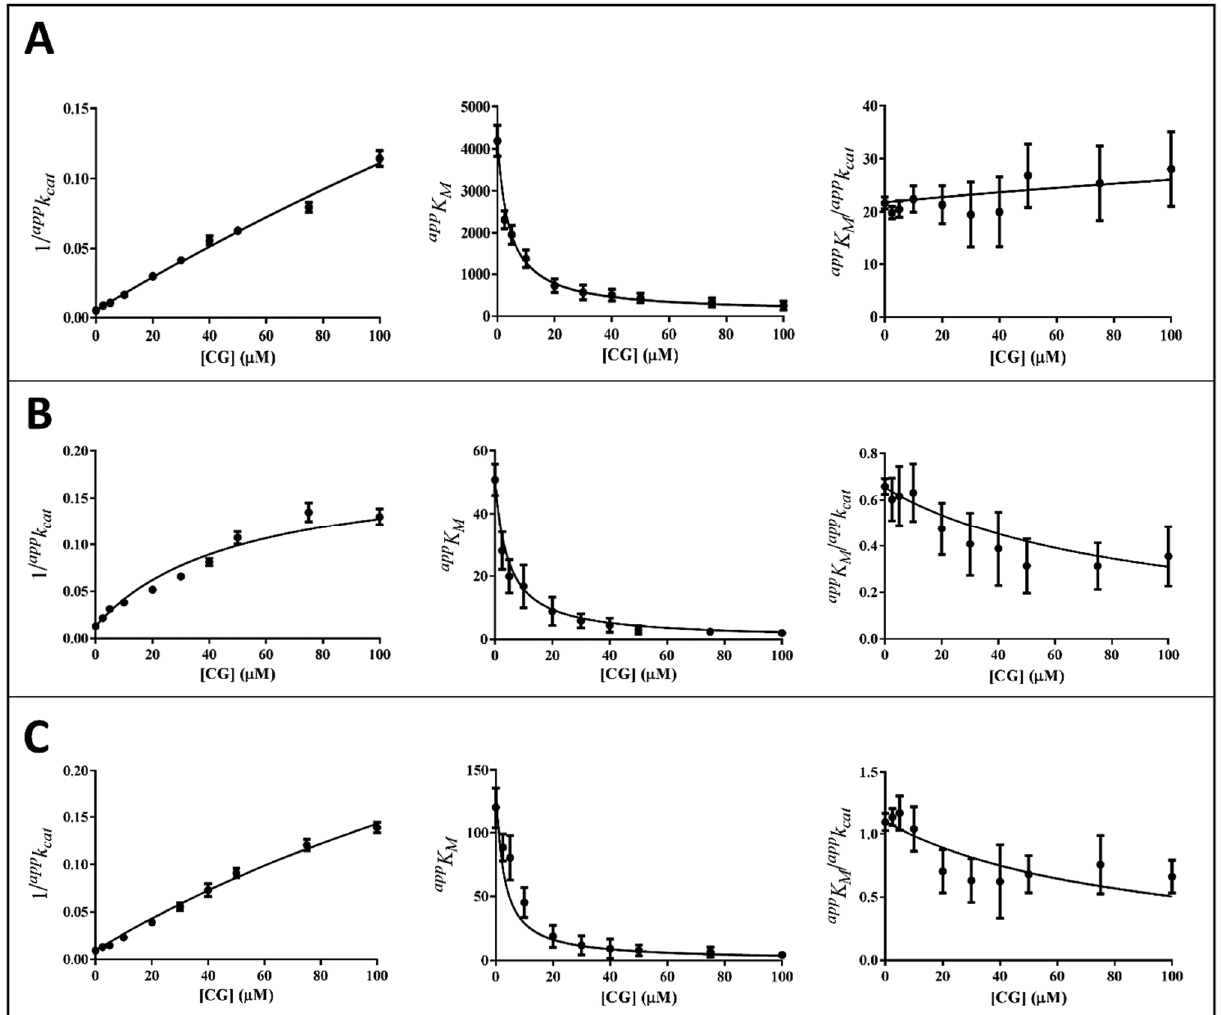
Figure 4. Kinetic analysis of CG inhibition of the AKR1B1-dependent reduction of different substrates. Panel ( A – C ) refer to L-idose, HNE, and GSHNE, respectively. The secondary plots of apparent kinetic parameters at different GCG concentrations derived from the non-linear regression Michaelis–Menten analysis of primary kinetic data reported in Figure 3B. Bars (when not visible are within the symbols size) represent the standard error of the measurements. The parameters 1/ app k cat , app K M , and app K M/app k cat versus [I] were interpolated by non-linear regression using Graphpad Software 7.04. See the text for details.